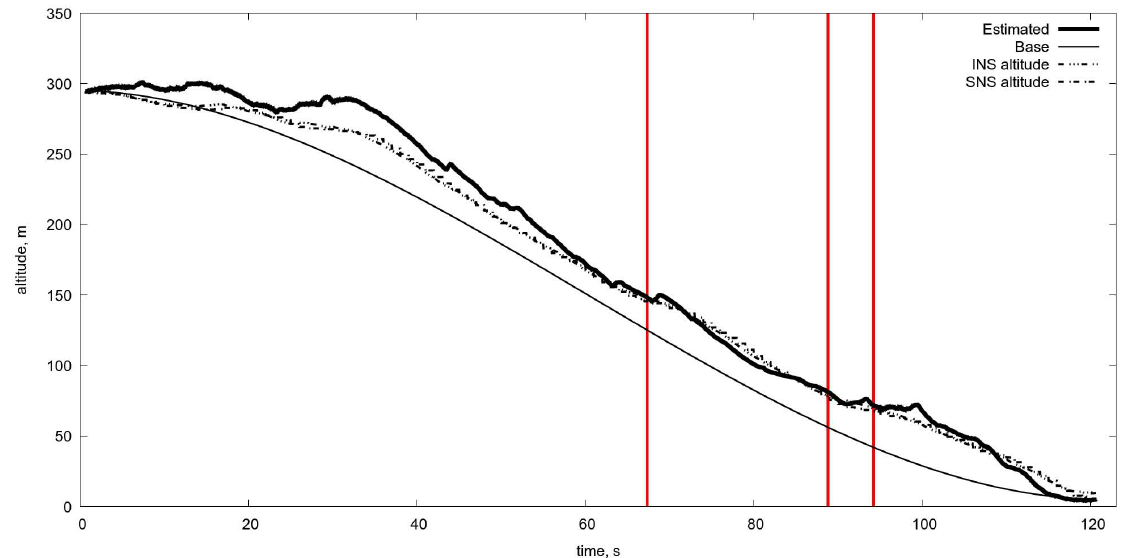
Figure 15. The altitude estimation via optical flow with switching averaging scale. The estimation of the altitude is made on the basis of standard Kalman filtering by fusion of data from the control system and the optical flow measurements. Of course, at low altitudes, less than 25–30 m, the OF measurements are corrupted by very high noise, but the usage of dynamical model and data from control system permit estimate reliably the altitude up to 5 m. Estimated is the altitude obtained by OF and Kalman filtering. Base is the program motion. INS is the altitude from the inertial navigation system. SNS is the altitude from the satellite navigation